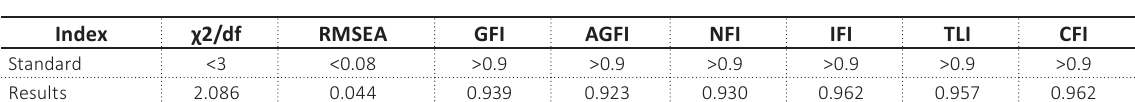
Table 4. Model fitting results